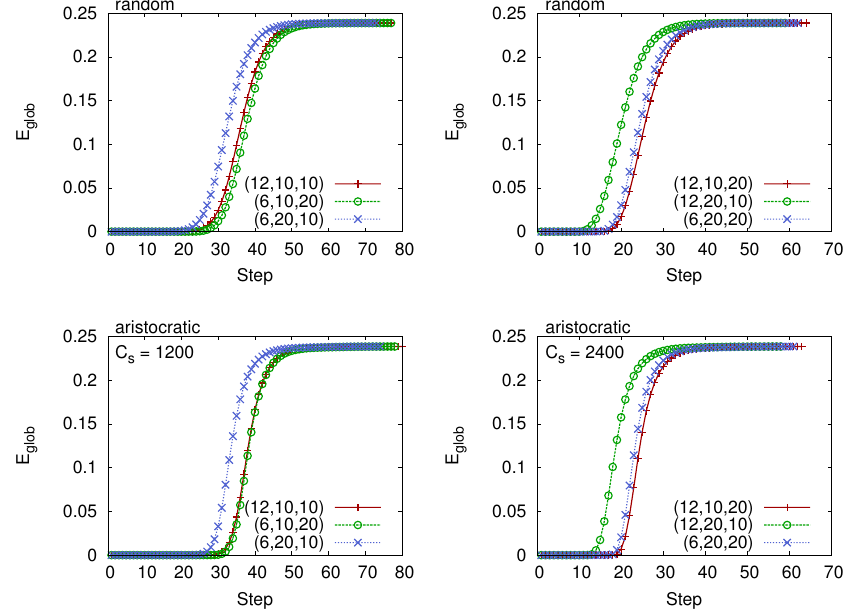
Figure 10. The figures describe the benefit of higher attractiveness for the same cost configurations of the Communities online social network. In particular, we selected broadcast model, random ( top panels ), and aristocratic ( bottom panels ) rules. Two cost levels have been considered: C s = 1200 ( left panels ) and C s = 2400 ( right panels ). Configurations ( 6,20,10 ) and ( 12,20,10 ) outperform the others and in this case network efficiency will start to increase earlier, regardless of the growing rule of the users’